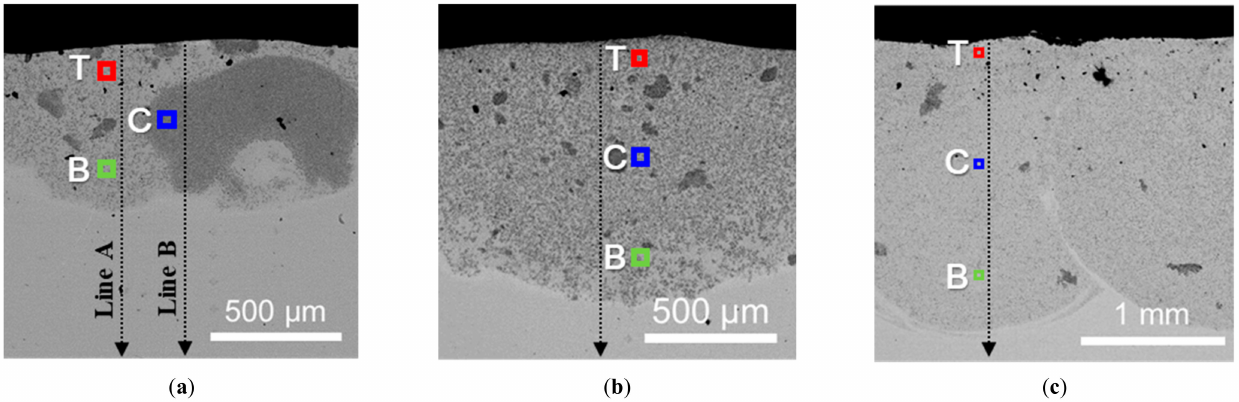
Figure 3. Cross-section image of coating layer ( a ) EEMMC1.0, ( b ) EEMMC1.5, and ( c ) EEMMC2.0. The squares represent the locations where the magnified microstructure images were taken, and the dotted lines are hardness measurement positions, which are employed in the following figures.